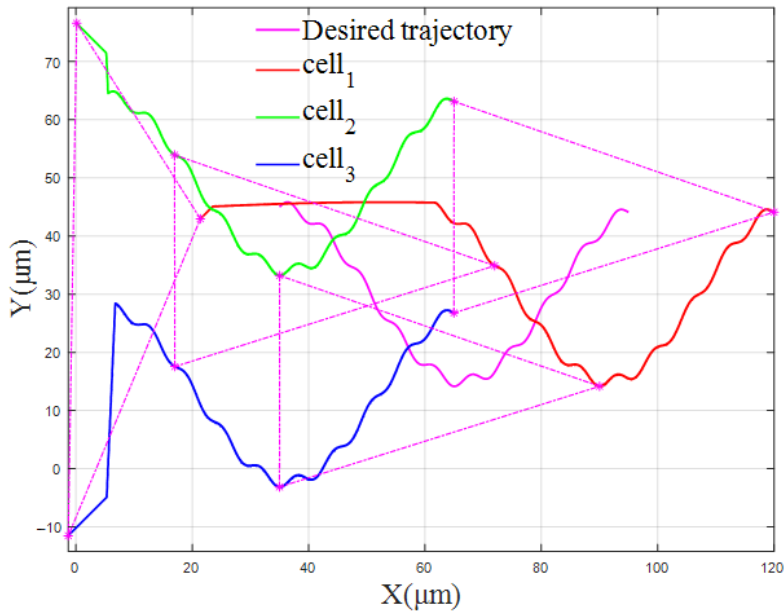
Figure 15. The cell trajectory of the triangular formation ( β /k = 0.09).